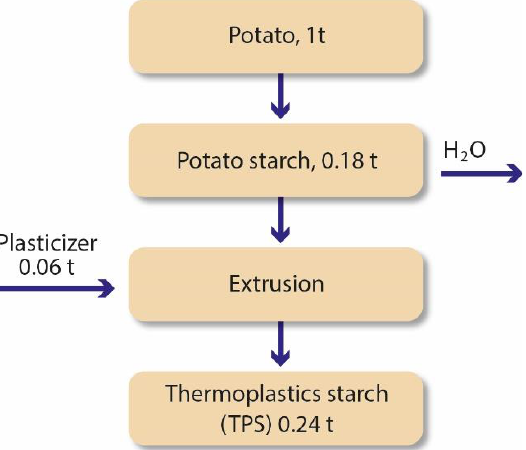
Figure 4. Production flow chart of thermoplastic starch (TPS). Adapted from “Bioplastics: Develop- ment, Possibilities and Difficulties”, Environmental Research, Engineering and Management, vol. 68, no. 2, Jul. 2014, doi: 10.5755/j01.erem.68.2.6777 [36].